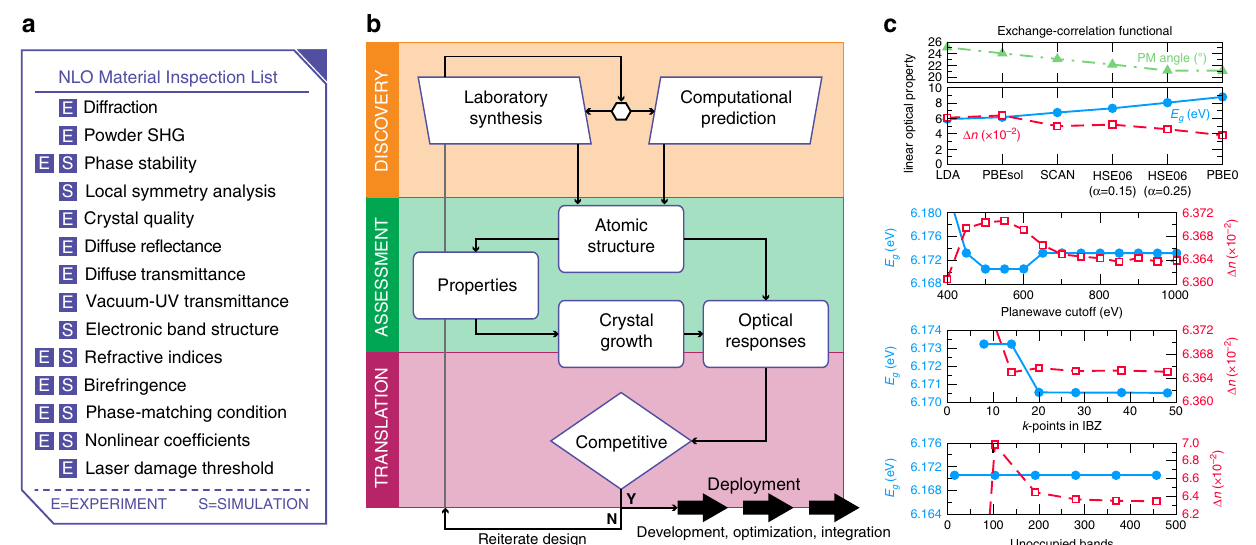
Fig. 2 NLO Materials inspection. a The experiment ( E ) and simulation ( S ) must-have and like-to-have checklist itemizes important measurements and analyses to perform on a candidate compound; wherever feasible, both types of assessments should be performed. b Discovery work fl ow highlighting the main property assessments required to determine functionality — commercial viability — of new laboratory discovered or computationally predicted DUV NLO materials. Computational researchers can then facilitate the experimental laboratory discovery (hexagonal link) by providing con fi dence estimates to the prediction. c For materials predictions without experimental data, the quality of the results should be addressed by considering how different levels of theory, e.g., exchange-correlation functionals to DFT (upper panel), impact the predicted optical properties and phase stabilities (formation energies) of the crystal. Effect of the numerical accuracies of the plane-wave expansion, k -point sampling of the irreducible Brillouin zone (IBZ) and number of unoccupied bands, on the linear optical properties from DFT-PBEsol calculations for the experimental KBe 2 BO 3 F 2 (KBBF)